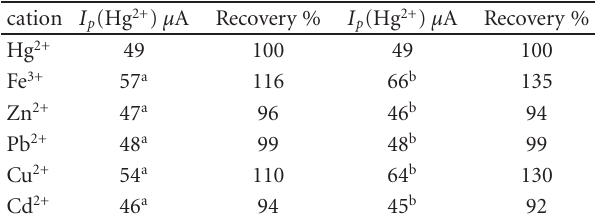
Table 1: The e ff ect of interference of some metal ions on mercury determination under optimized experimental conditions at AAP/GCE. Solution contains 1 µ moLL-1 Hg2+ and interferences are (a) 1 µ moLL-1 and (b) 10 µ moLL-1.